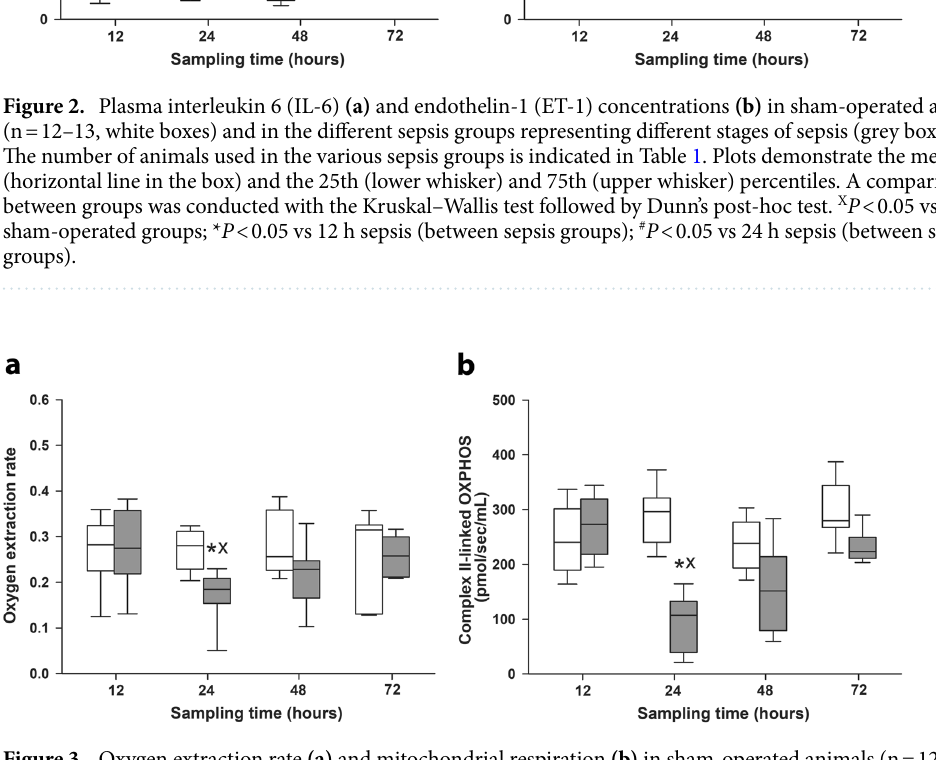
mortality was attributable to injection with E. coli monomicrobial cultures (Table 1). In the sepsis-inducing inocula, three bacterial phyla, including 18 mostly Gram-negative genera, could be detected. Specifically, the